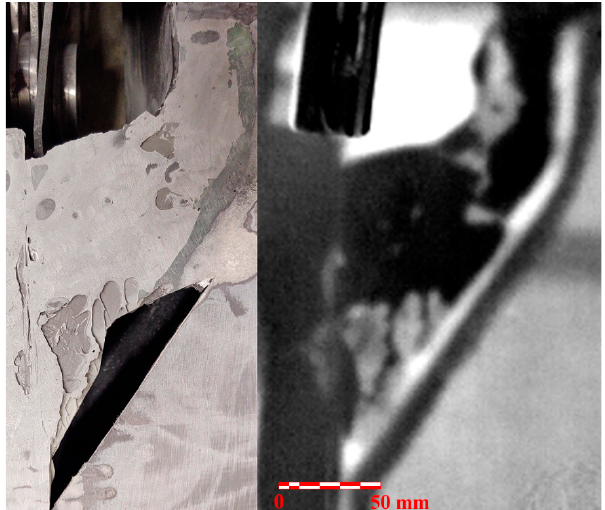
Figure 21. Comparison of NDE findings at the location of the flap lever seating ( right ) with the actual condition of the adhesive joint ( left ).